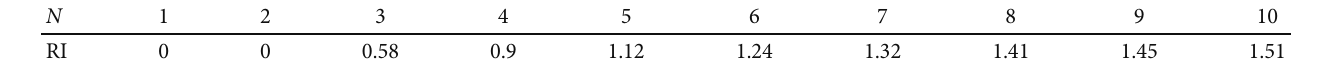
Table 4: Determination of the random index.